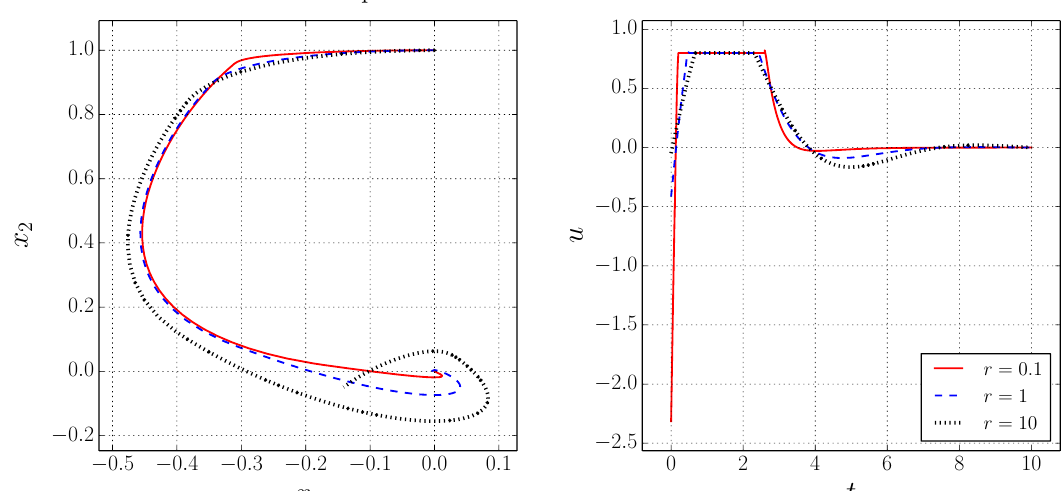
Figure 4. Optimal control of the Van der Pol oscillator. The initial state is (0, 1) and the objective is a quadratic penalty on the state and